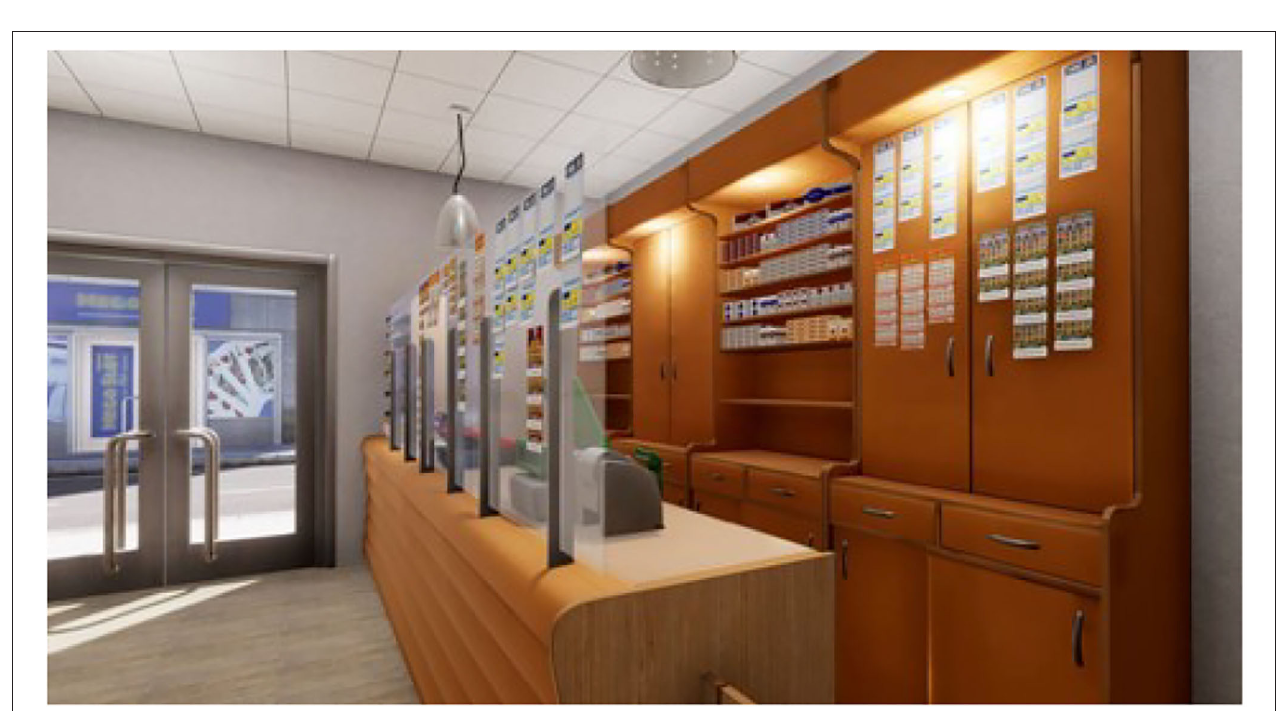
FIGURE 4 | A tobacco store with a view of the slot